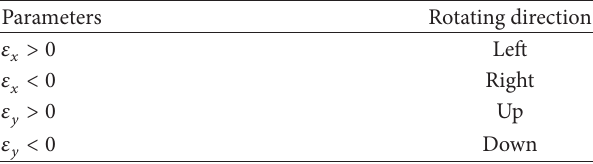
Table 1: The rotating direction of the PTZ camera.